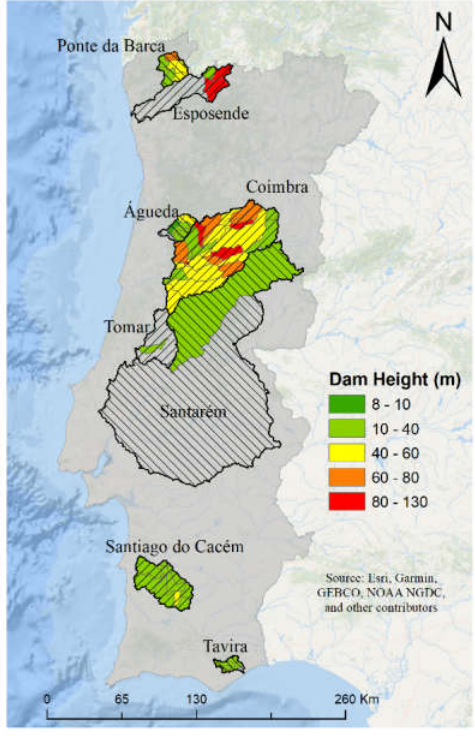
Figure 8. Spatial distribution of dam wall height.